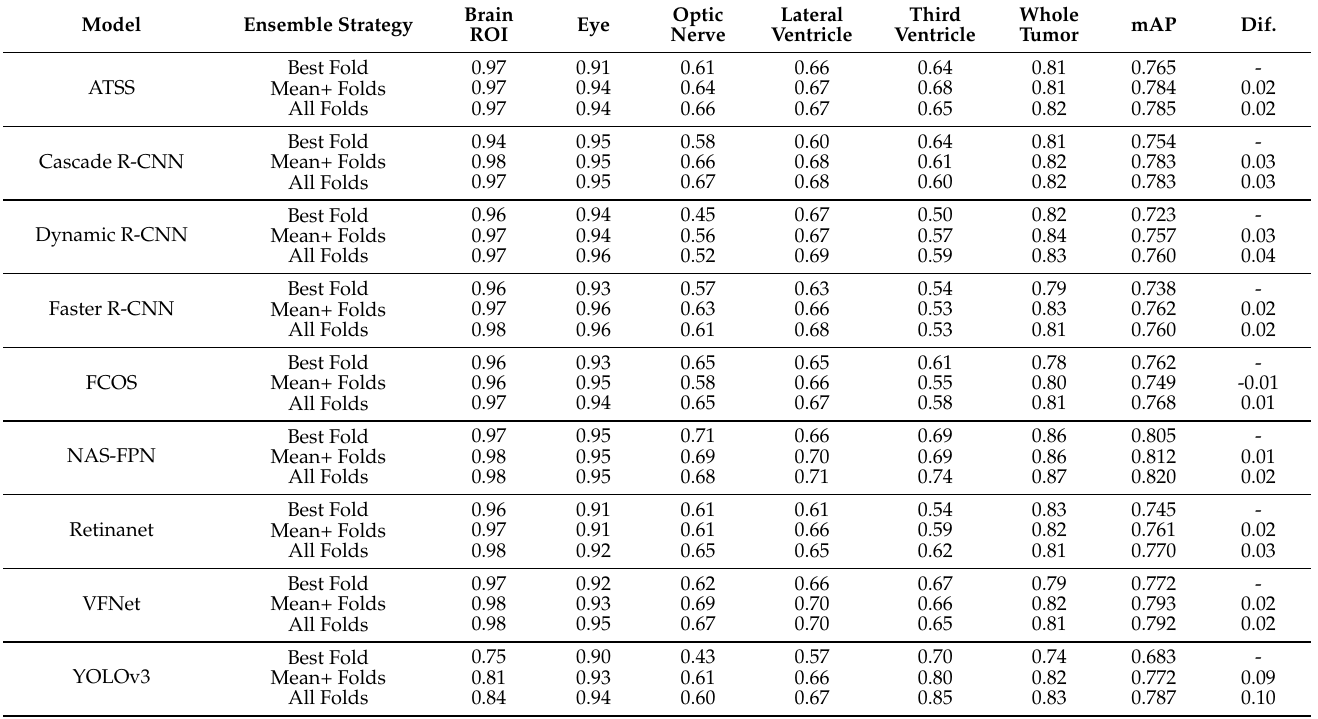
Table 5. Ensemble Strategy 1 and 2 results for each model.